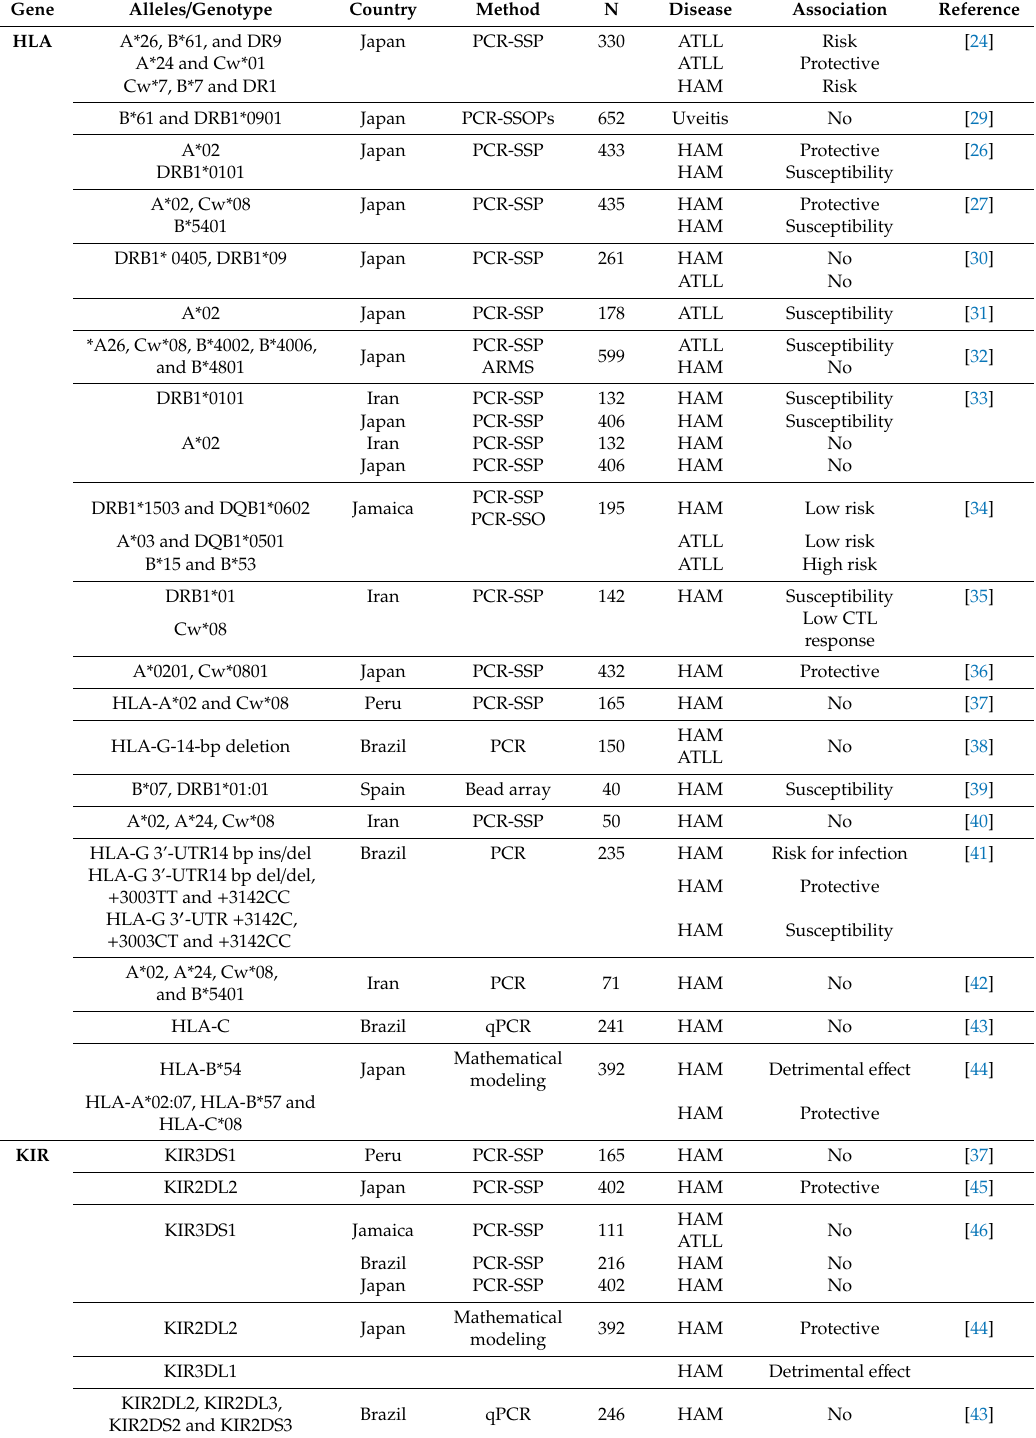
Table 1. Main polymorphisms in HLA and KIR genes associated with HTLV-1